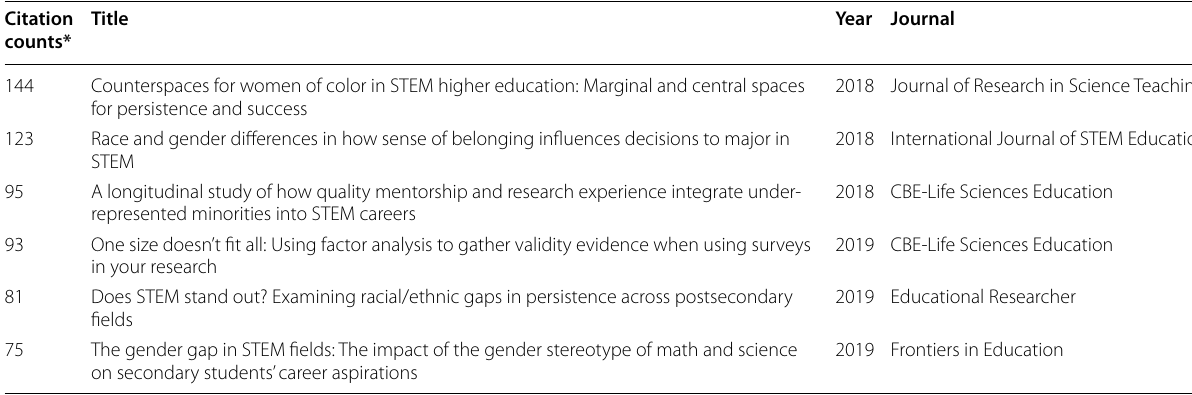
Table 5 Six highly cited research articles published in 2018 and